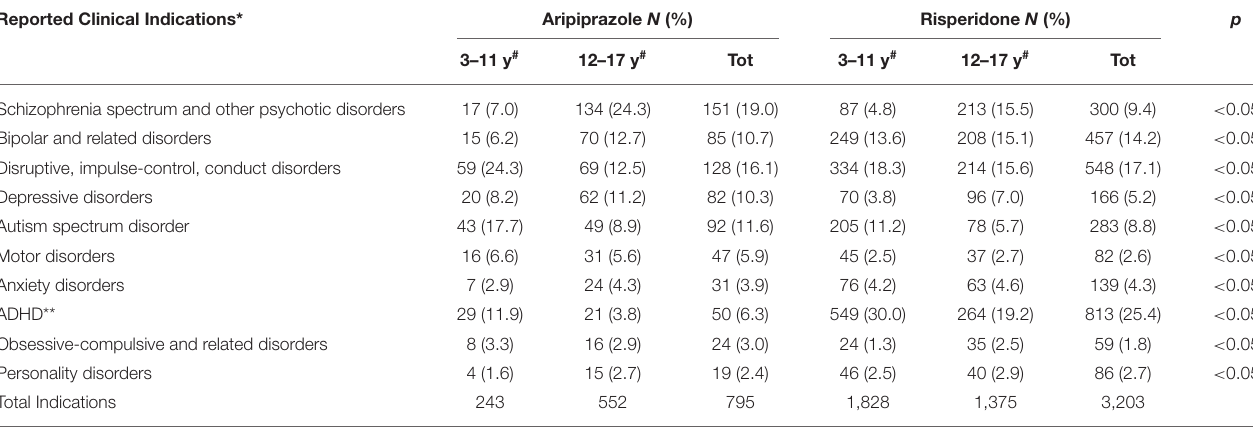
TABLE 3 | Distribution of reported clinical indication of use for aripiprazole and risperidone.